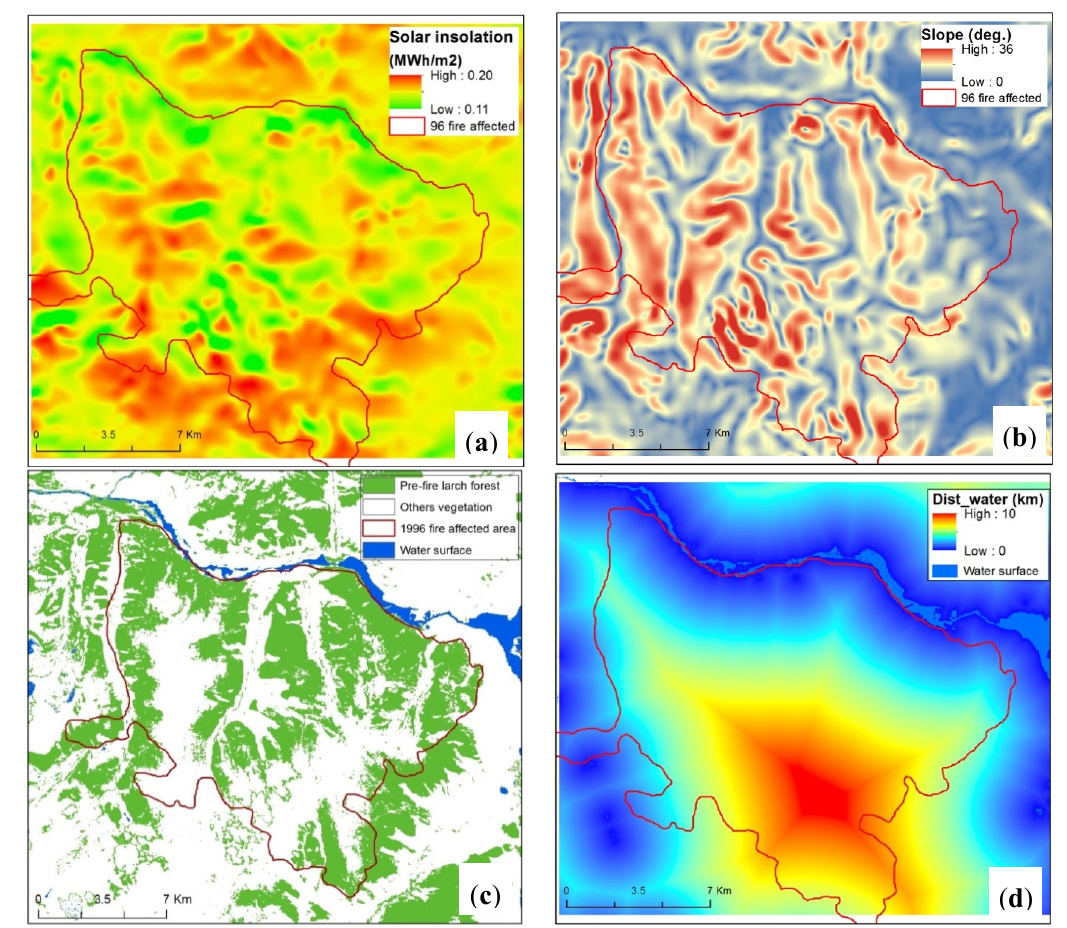
Figure 7. Examples of the topographic and landscape variables. Average solar insolation of summer months ( a ) and slope map ( b ) were derived from the surface analysis of a digital elevation model. Classification of pre ‐ fire land covers using the 1995 integrated forest z ‐ score ( c ) and the distance to water body using Euclidean distance ( d ). The water surface was masked using a 1995 NDVI Landsat image.